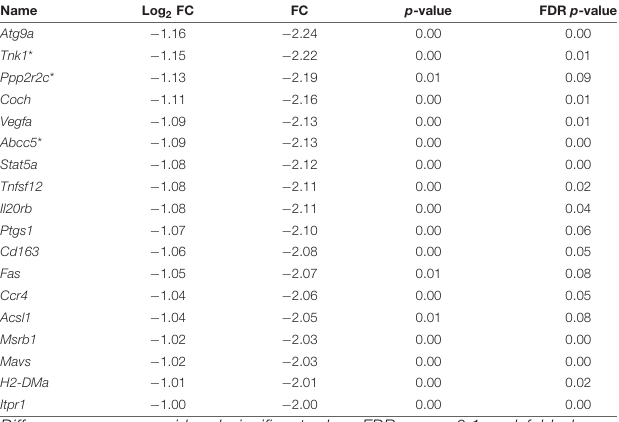
TABLE 3 | Antimicrobial associated genes differentially modulated in BALB/c skin as compared with C57BL/6